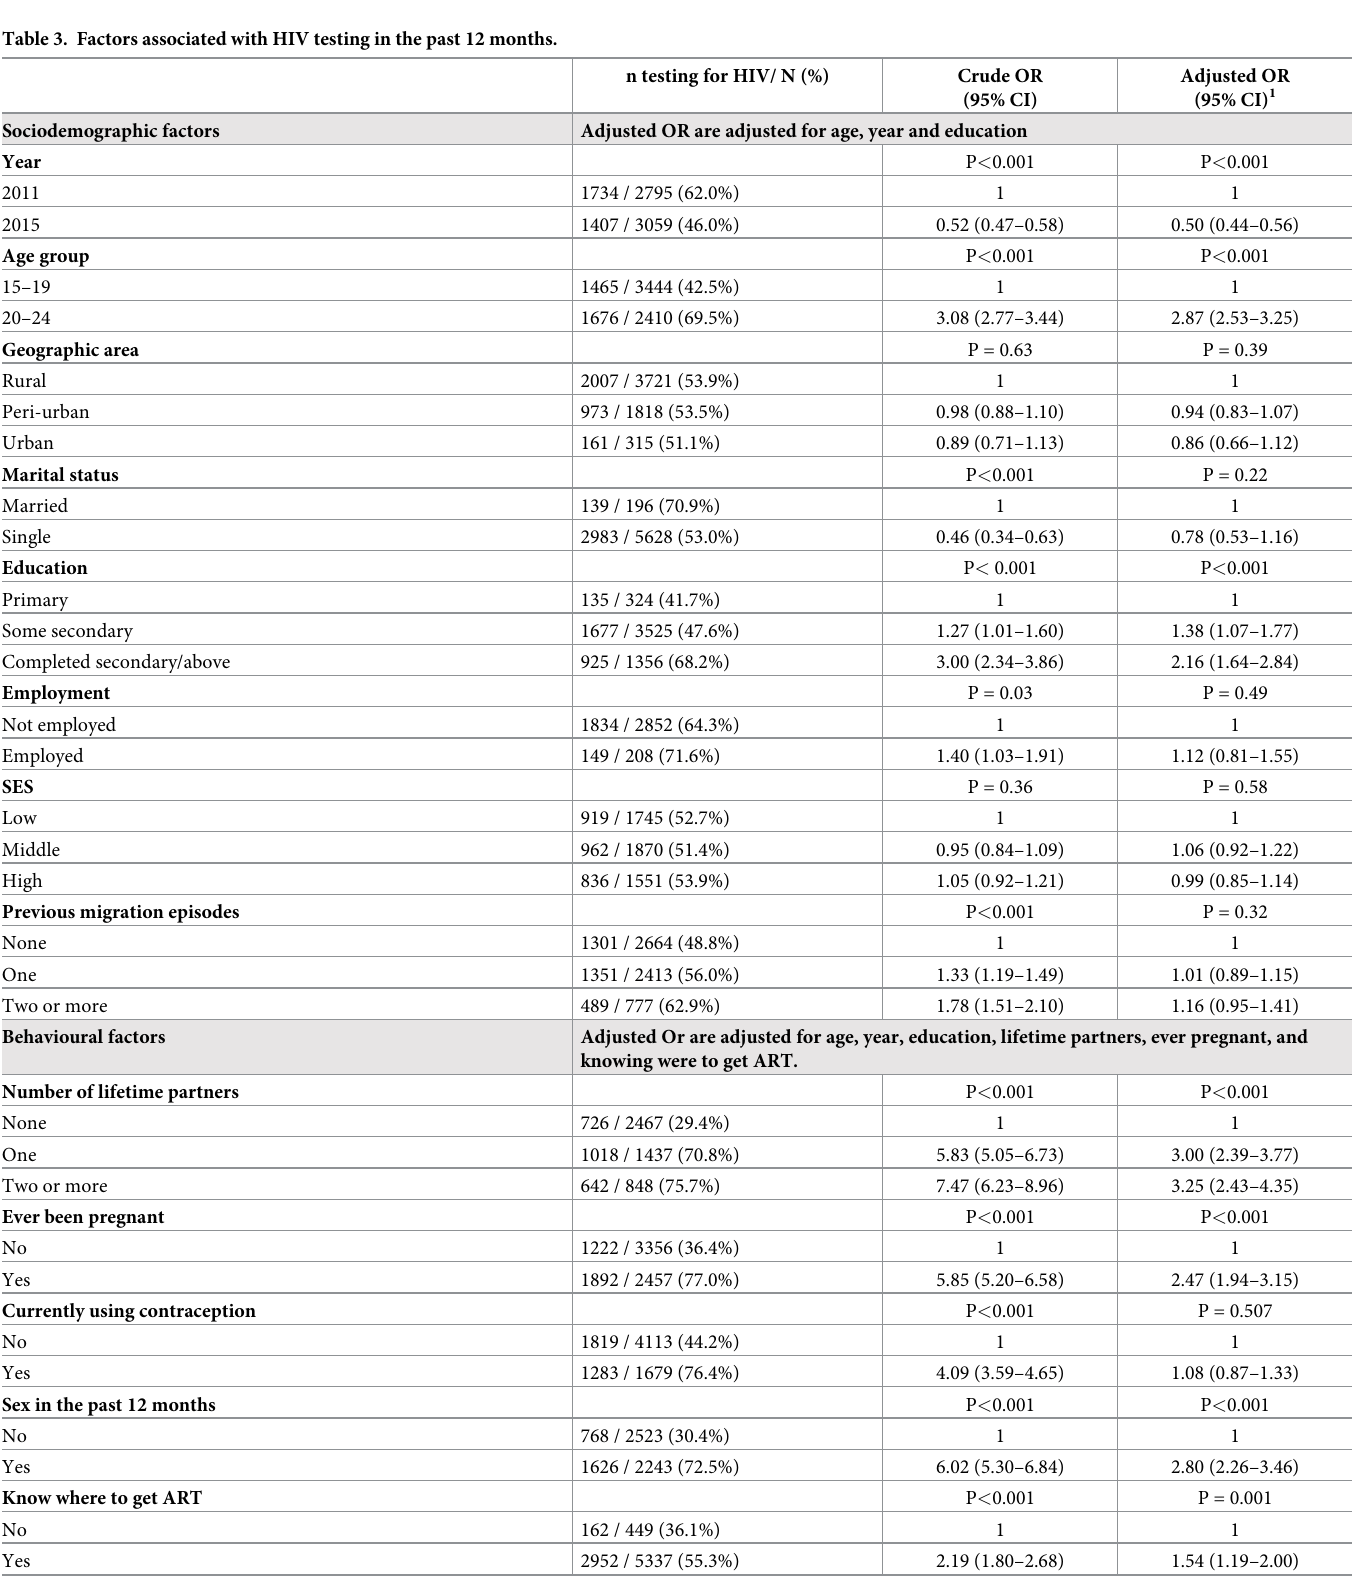
Table 3. Factors associated with HIV testing in the past 12